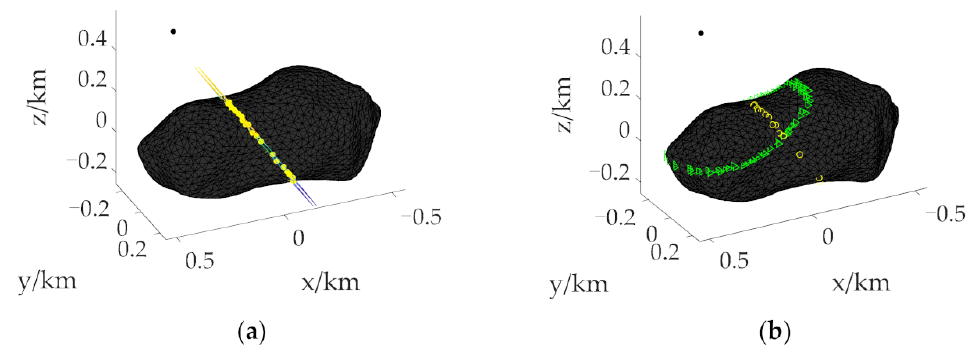
Figure 2. Use of the section method. ( a ) Solving a point on the initial boundary by the section method. ( b ) A group of asteroid surface points used to solve the initial boundary. The yellow “o” stand for points with feasible solutions between parallel planes. The green “ ∆ “stand for points between parallel planes when solving initial